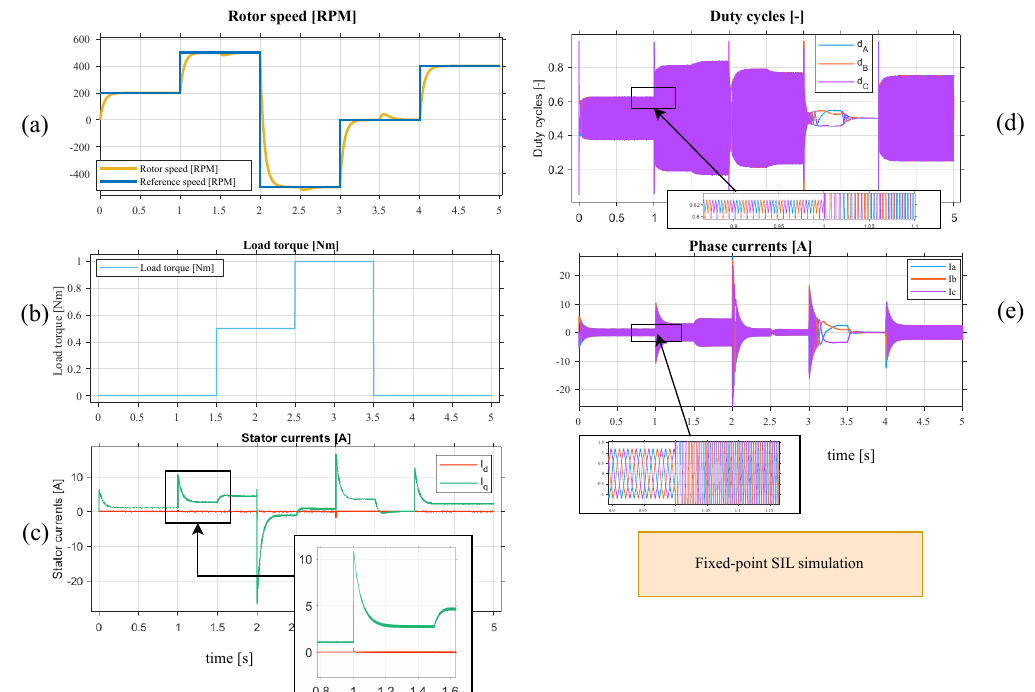
Figure 14. Software-in-the-loop simulation of the speed controller: ( a ) rotor speed [RPM]; ( b ) load torque [Nm] ( c ) stator currents [A]; ( d ) three-phase duty cycles; ( e ) three-phase currents [A].